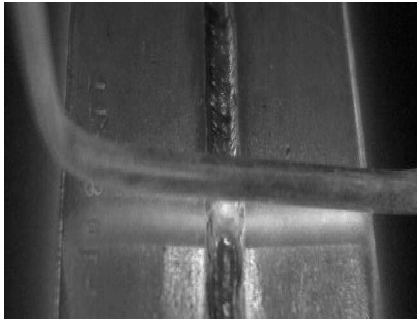
Figure 7. Principle components calculated from thermal sequences of welding line sample (e).